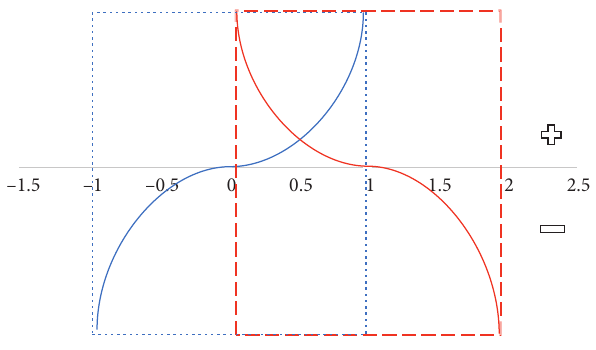
Figure 1: Diagram of